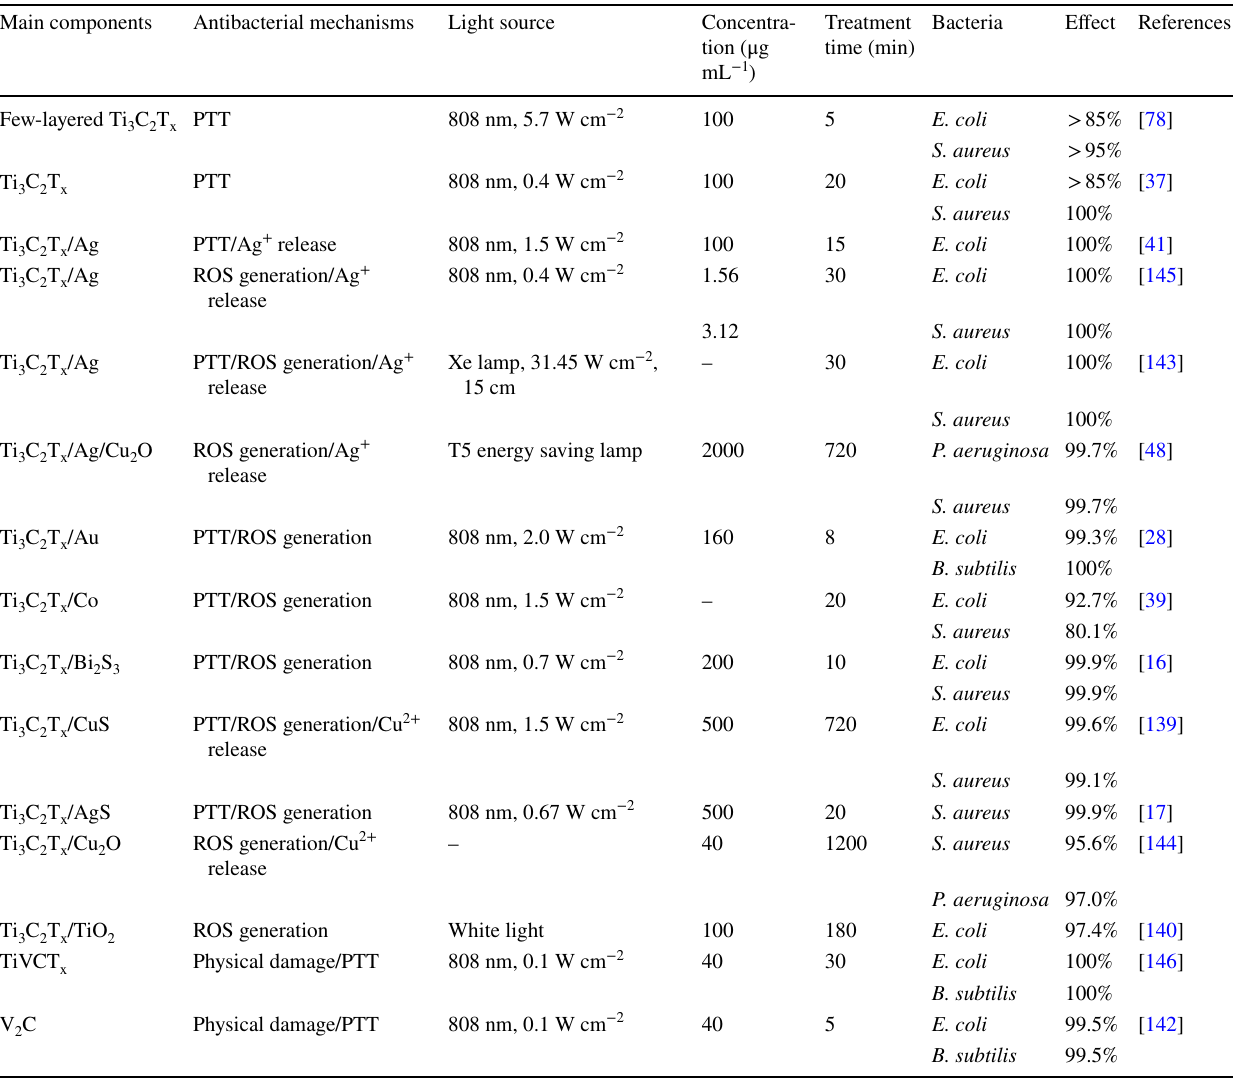
Table 3 Summary of in vitro photothermal-derived antibacterial applications using MXenes-based materials Main